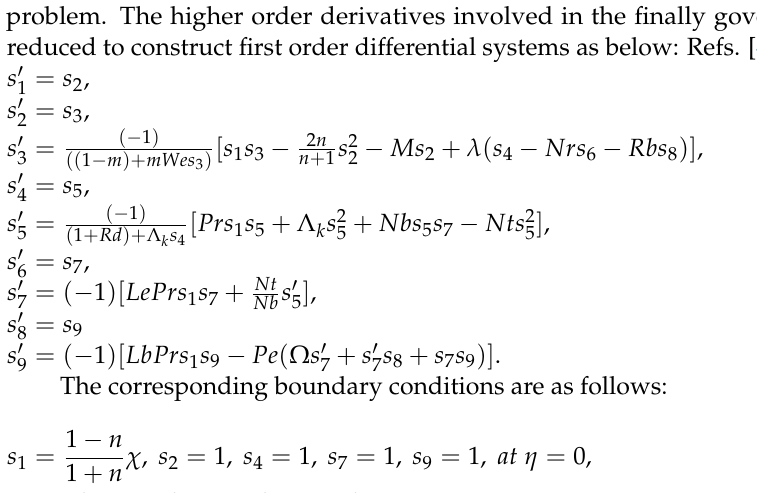
1 2 x for various values of m by ignoring other parameters.